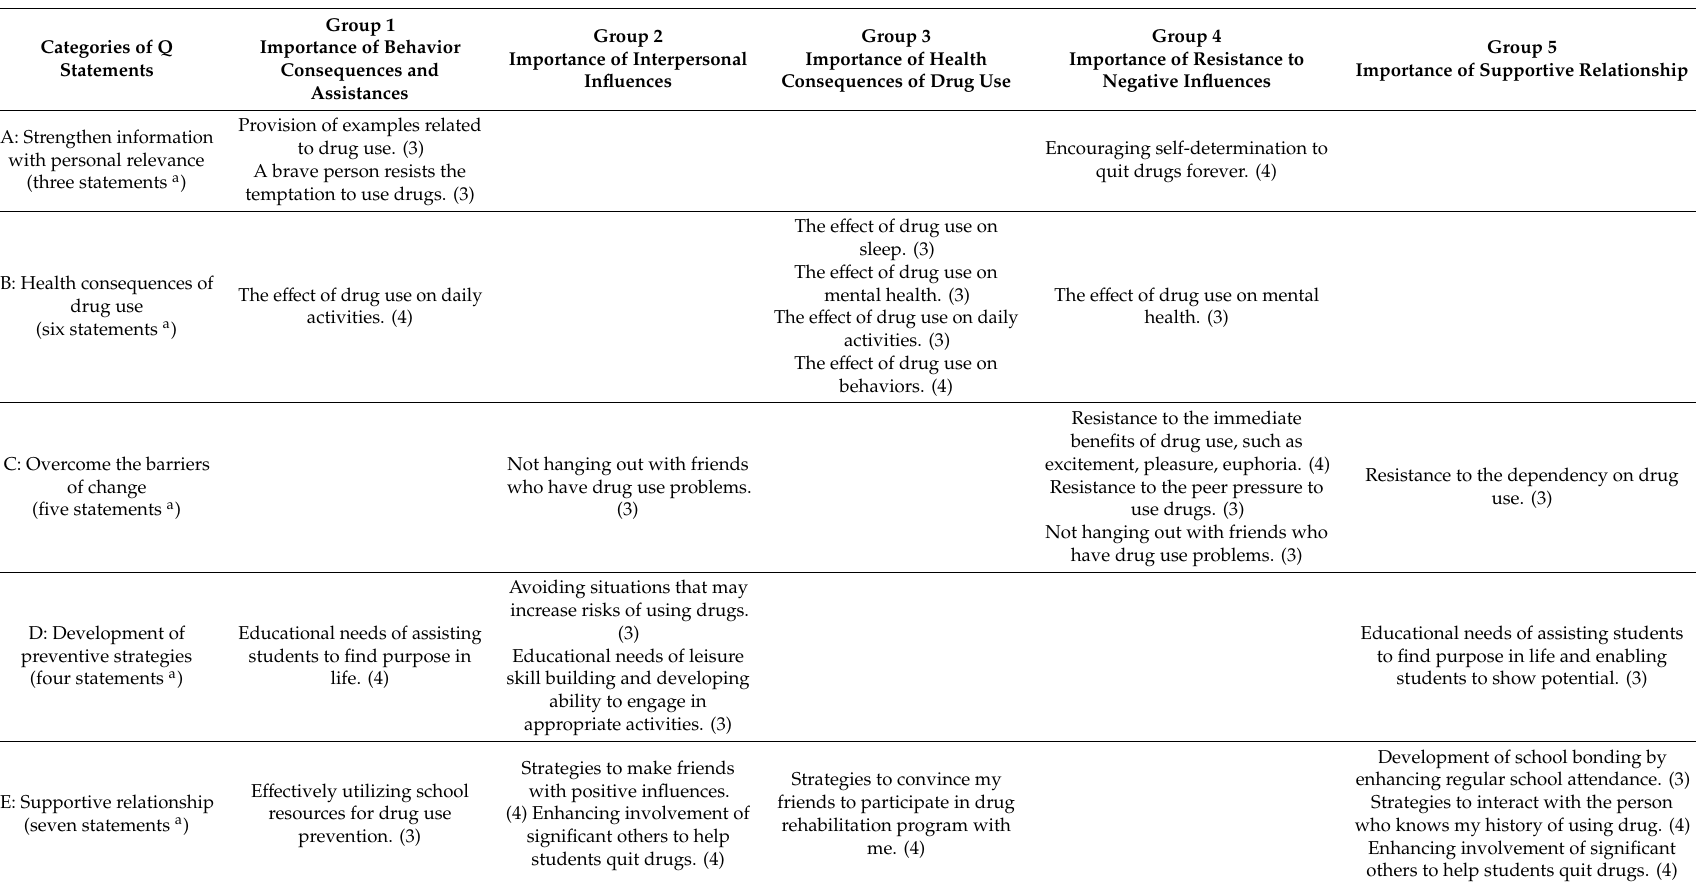
Table 4. Characterizing